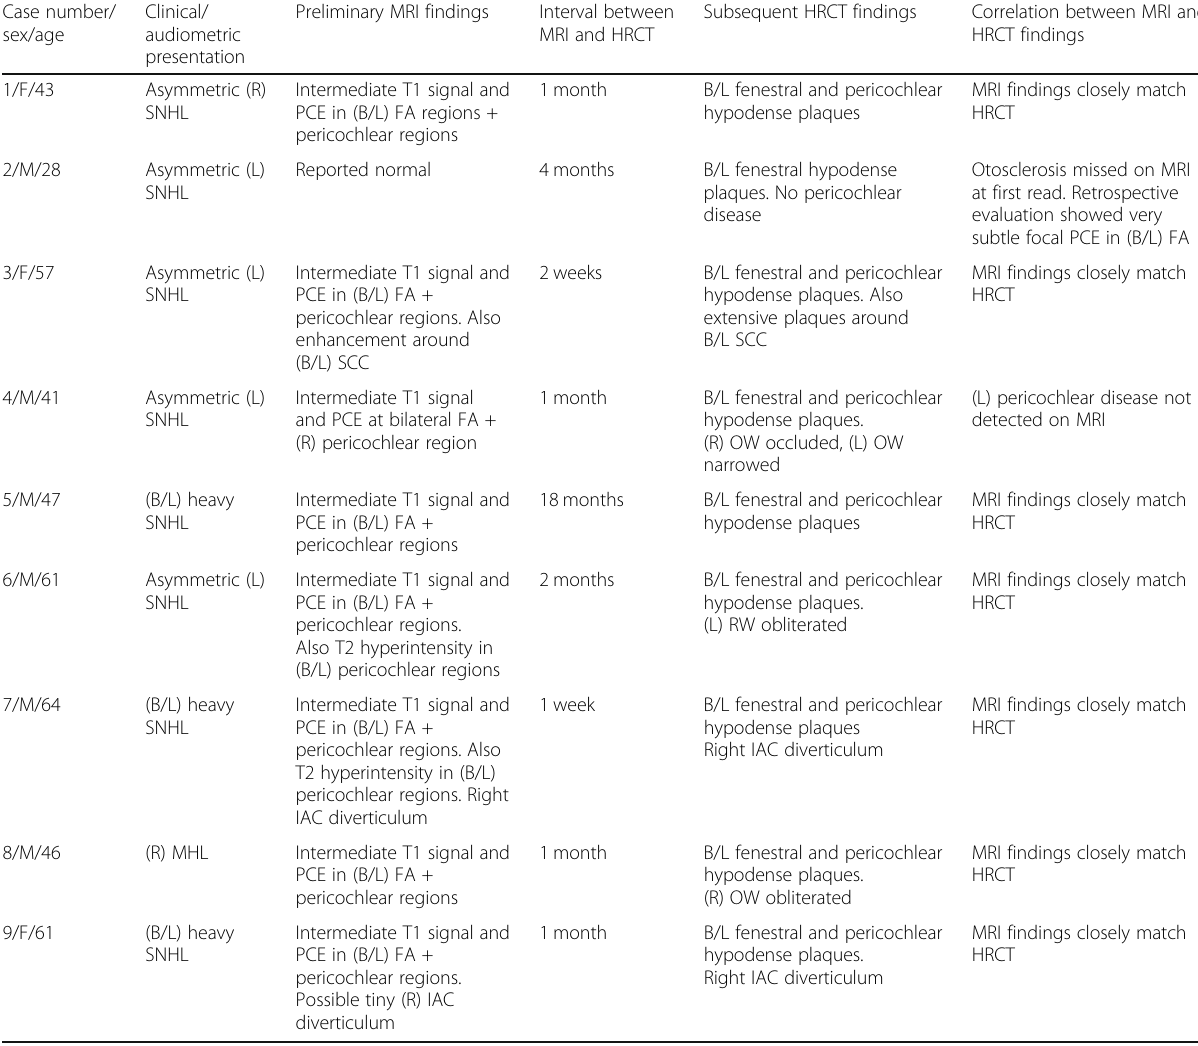
Table 1 Clinical presentation, MRI and HRCT findings of 9 patients who underwent first-line MRI and ultimately confirmed as otosclerosis on subsequent